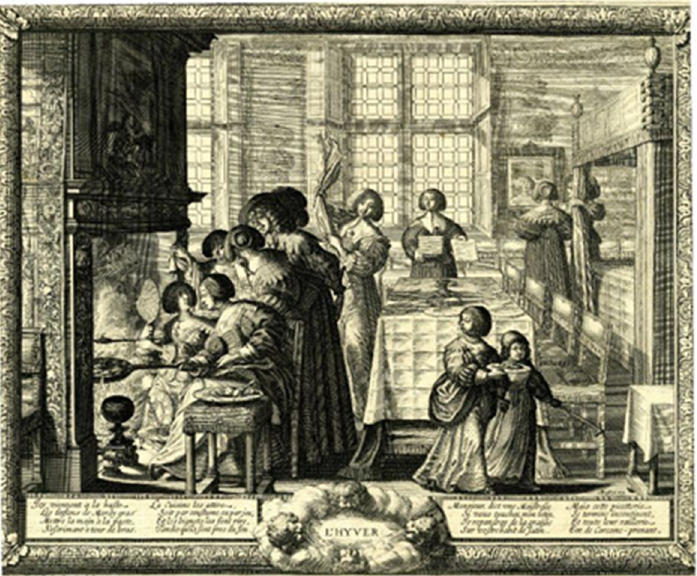
Figure 8. Abraham Bosse (French, 1604–1676), L’Hyver , 1635–1637, Etching, 26.2 cm × 32.8 cm, The Metropolitan Museum of Art, New-York; Harris Brisbane Dick Fund, 1926.